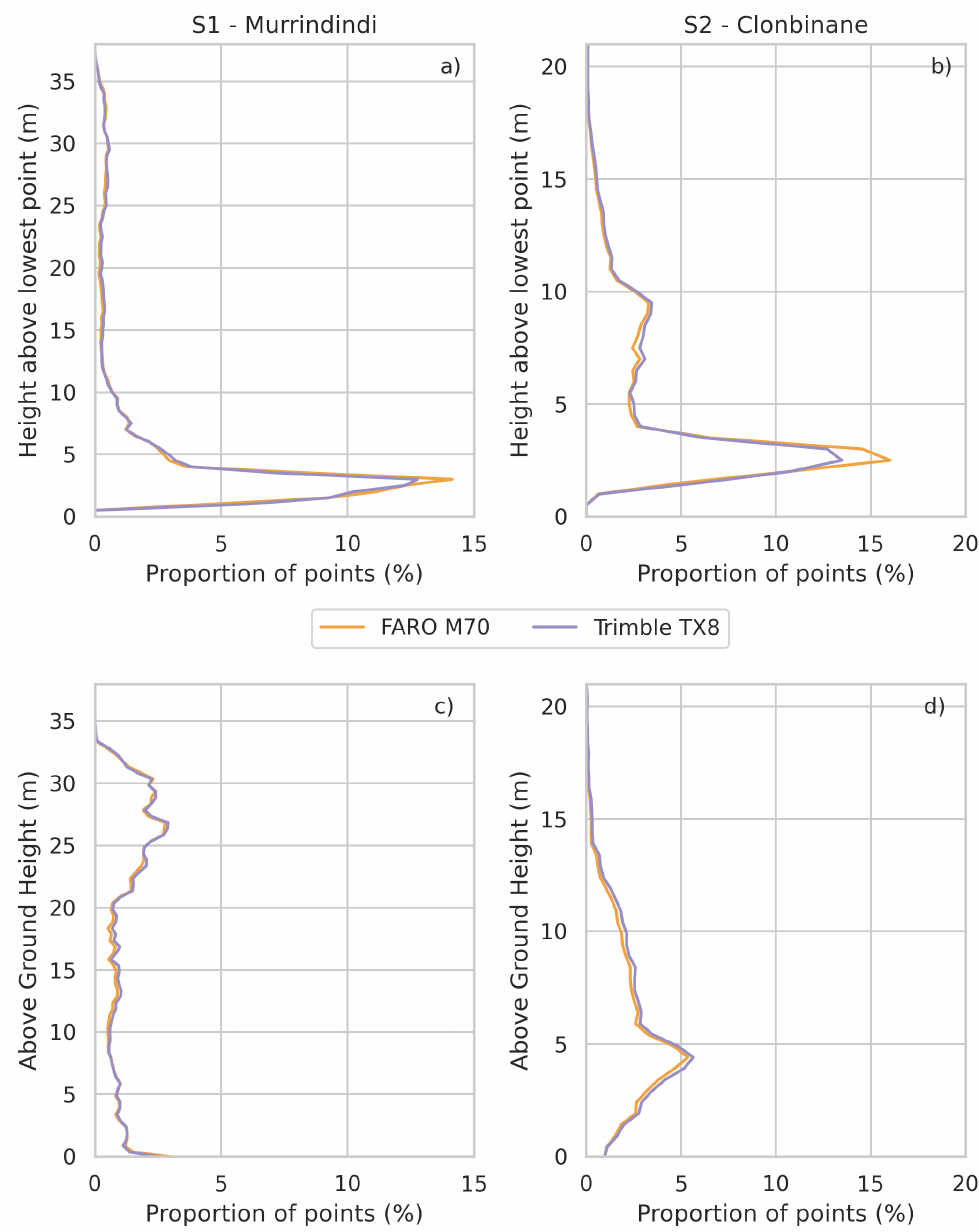
Figure 2. Height distribution of point clouds captured by the M70 (green) and TX-8 scanners (pink) at ( a ) S1—Murrundindi and ( b ) S2—Clonbinane relative to the lowest returned point. Above ground height distributions of filled voxels derived from these point clouds at ( c ) S1 and ( d )